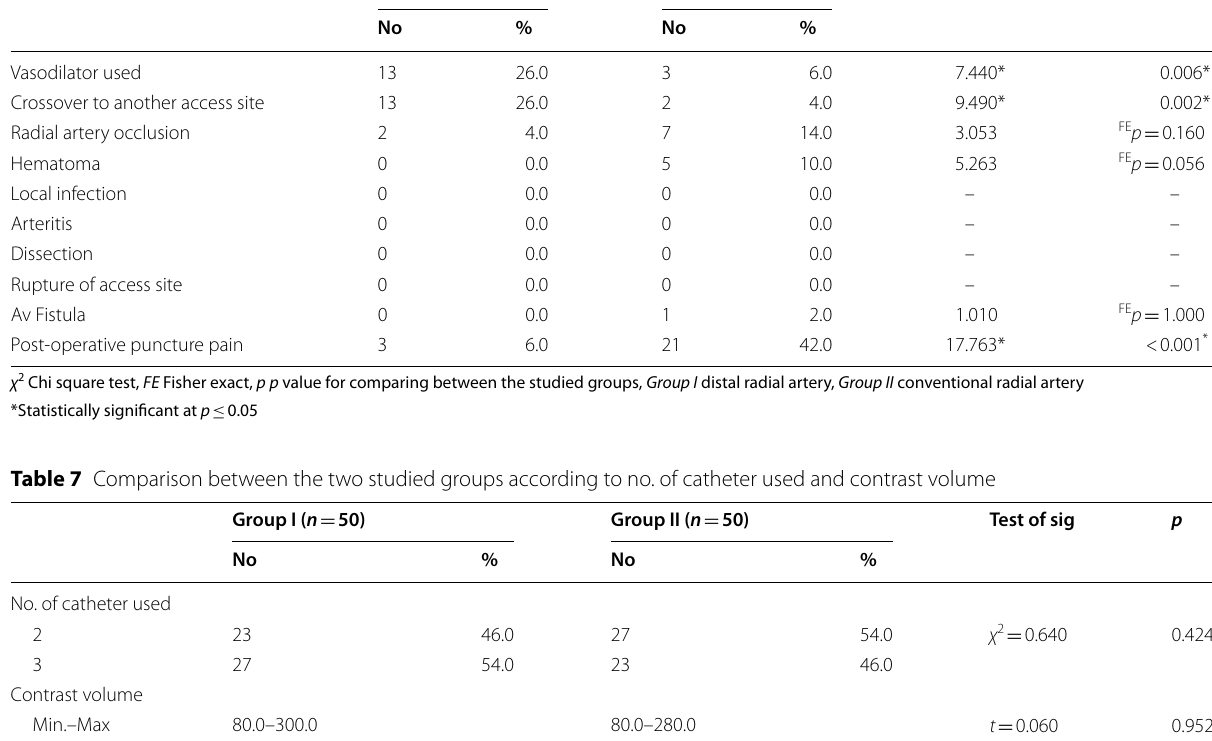
Table 6 Comparison between the two studied groups according to different parameters